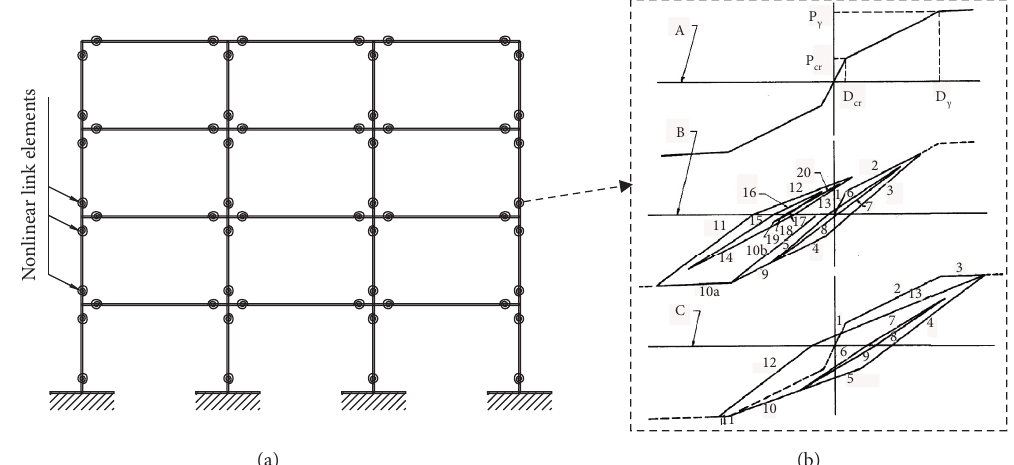
Figure 2: Modelling for inelastic analyses: (a) modelling and (b) hysteretic behaviour [44].